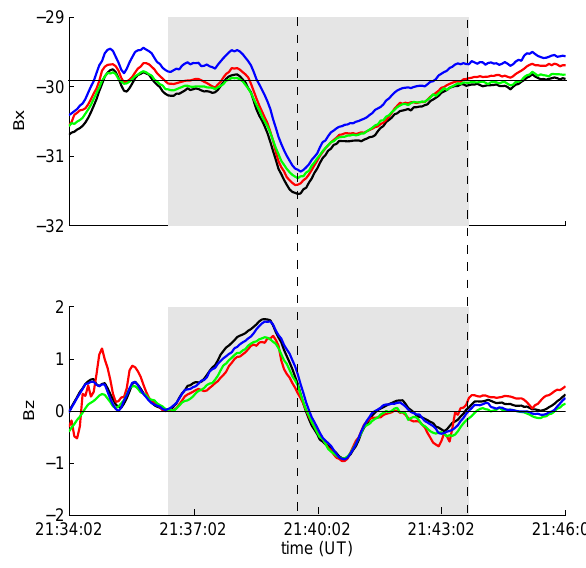
Fig. 8. TCR5: B x and shifted B z for the fifth TCR. The horizontal line in the upper panel denotes the approximated background B x with respect to C1, C2 and C3. The variation in B x ends at about 21:43:38UT, denoted by a vertical dashed line. The first dashed line represents the maximum in | B x |